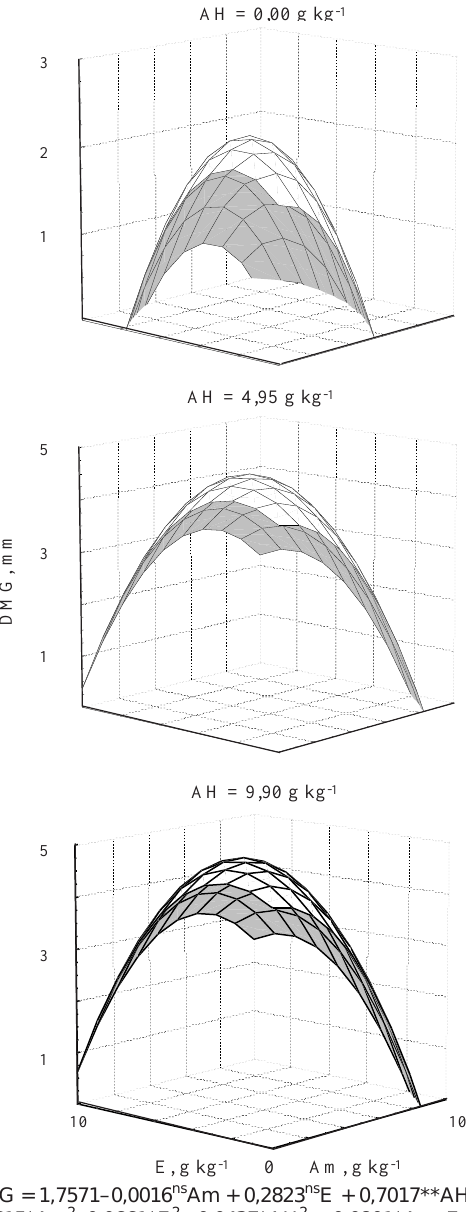
Figura 4. Diâmetro médio geométrico (DMG) dos agregados do horizonte B analisado por via seca, considerando a adição de amido (Am) e ácido esteárico (E), para diferentes doses de ácido húmico (AH).